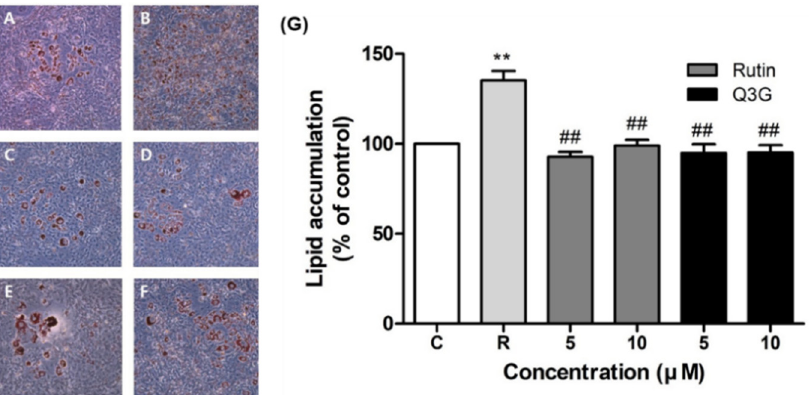
Figure 6. Representative images (magnification ×100) of Oil-Red-O staining in 3T3-L1 cells treated with ( A ) vehicle (control), ( B ) rosiglitazone 10 μ M, ( C ) rutin 5 μ M, ( D ) rutin 10 μ M, ( E ) quercetin- 3- O - β - D -glucoside (Q3G) 5 μ M, and ( F ) Q3G 10 μ M ( F ). ( G ) Effect of rutin and Q3G on lipid accumulation in 3T3-L1 adipocytes. Data are means ± standard error of the mean (SEM, n = 3); ** p < 0.01 versus control and ## p < 0.01 versus rosiglitazone 10 μ M. C, control; R, rosiglitazone 10 μ M.